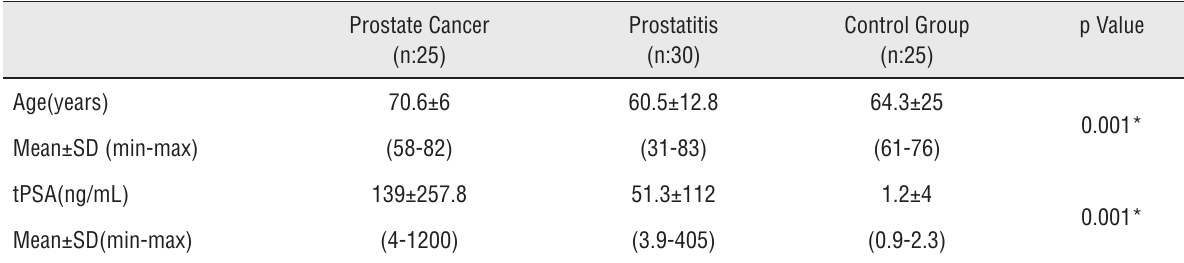
Table 1 - Comparison of ages and serum t PSA